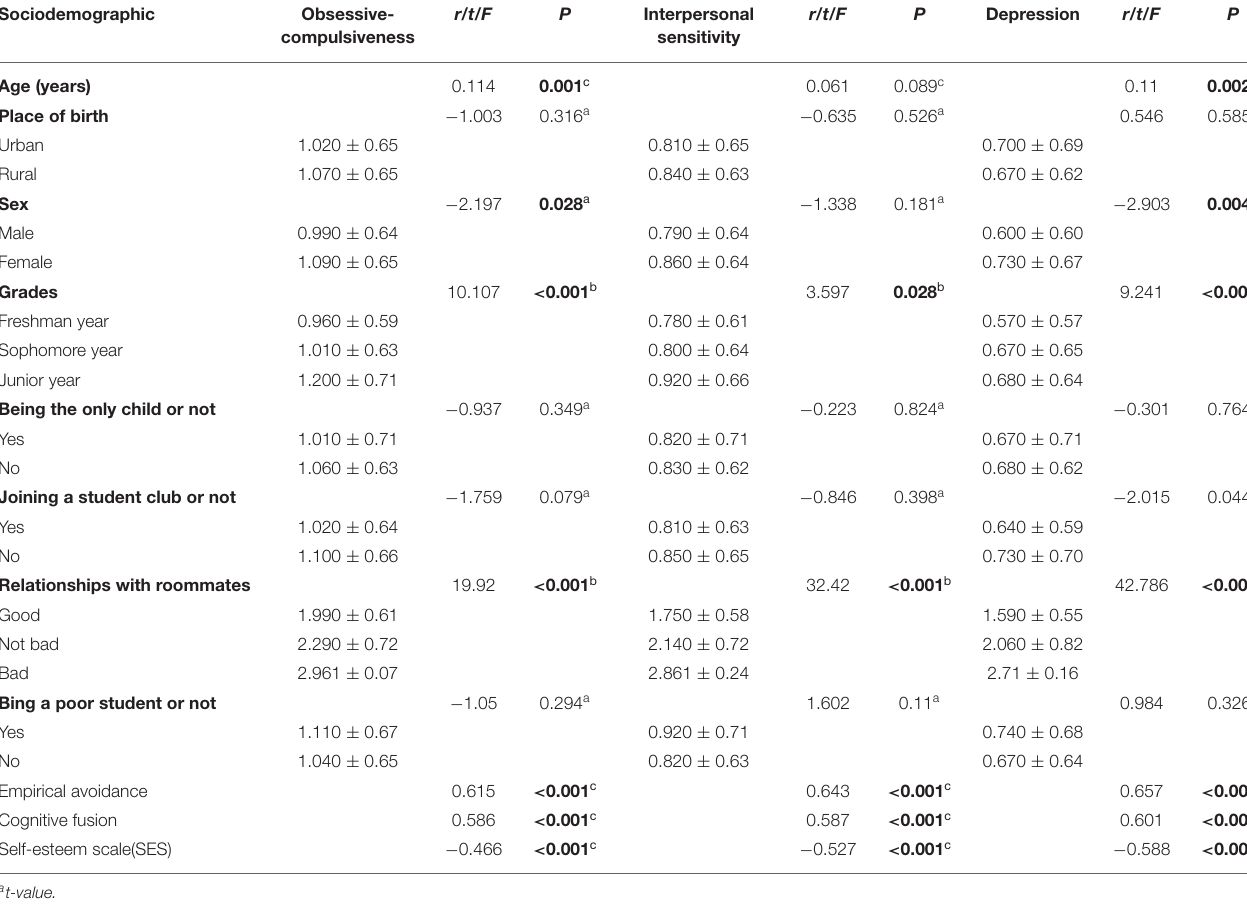
TABLE 3 | Factors influencing obsessive-compulsiveness, interpersonal sensitivity, and depression symptoms (mean ± SD). Sociodemographic